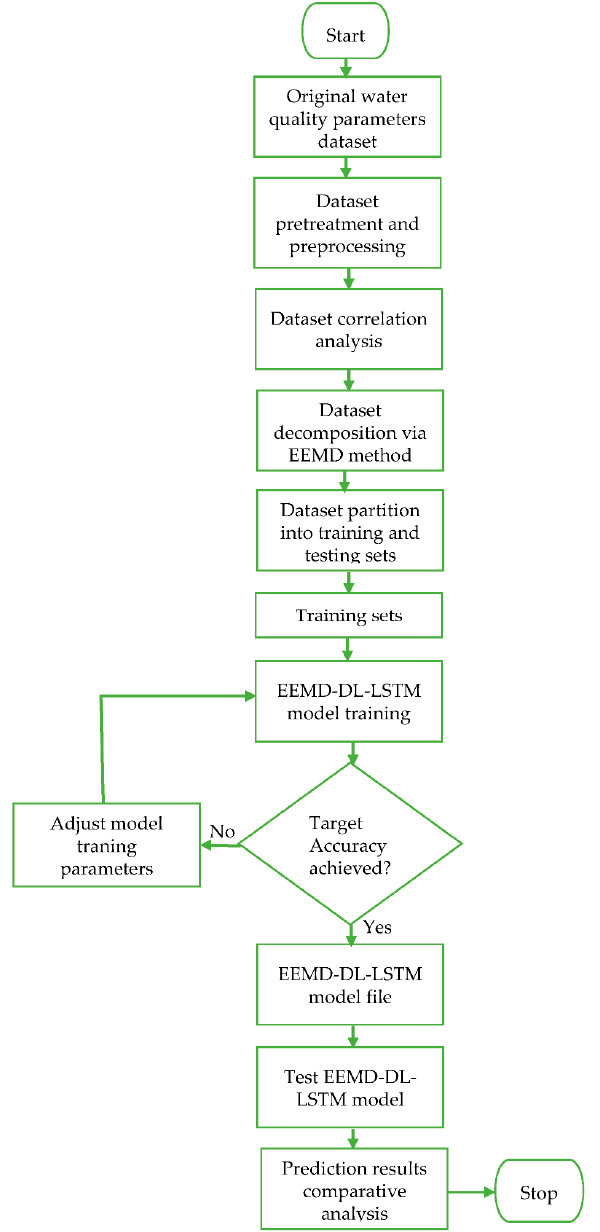
Figure 6. Complete flowchart of the proposed hybrid EEMD-DL-LSTM NN-based water quality parameters prediction model.